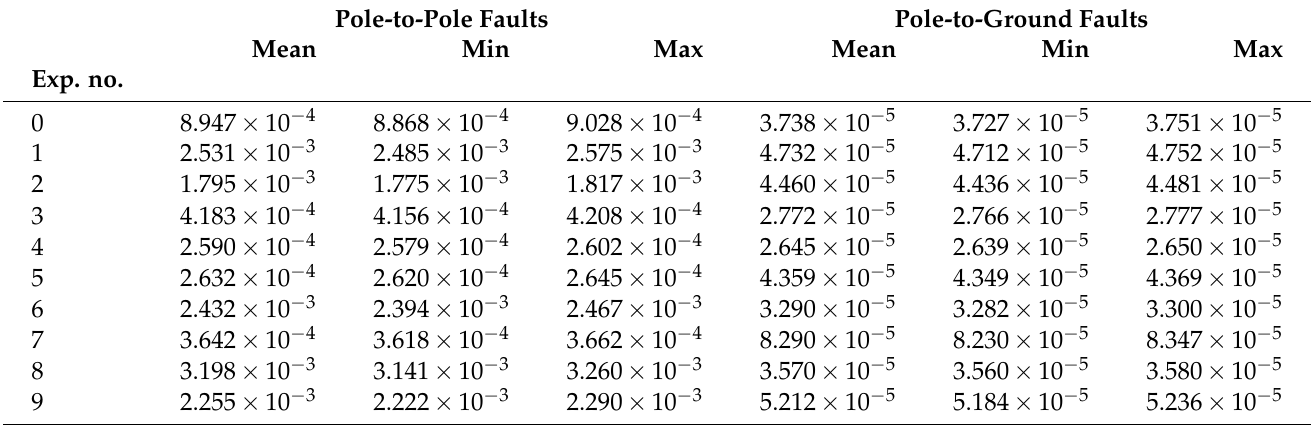
Figure 7. Application of the algorithm to two samples, one of pole-to-pole and one of pole-to-ground faults. ( a ) Bayesian model has efficiently captured the shape of measurements. ( b ) Distribution of data depth shows good discrimination of pole-to-ground from the reference depth; however, isolated pole-to-pole fault is also much more shallow. It suggests that current is a poor diagnostic indicator in this case. Table 2. When analyzing current signal in the context of reference depth of pole-to-pole fault (with mean of 6.23 × 10 − 2 and spreading from 1.993 × 10 − 2 to 2.14 × 10 − 1 ) we can see that it is not the best indicator. While pole-to-ground scenarios are being clearly discriminated as ‘shallow’ with depths at the level of 10 − 5 , the pole-to-pole current signals are also separated from the reference not getting depths greater than 10 − 3